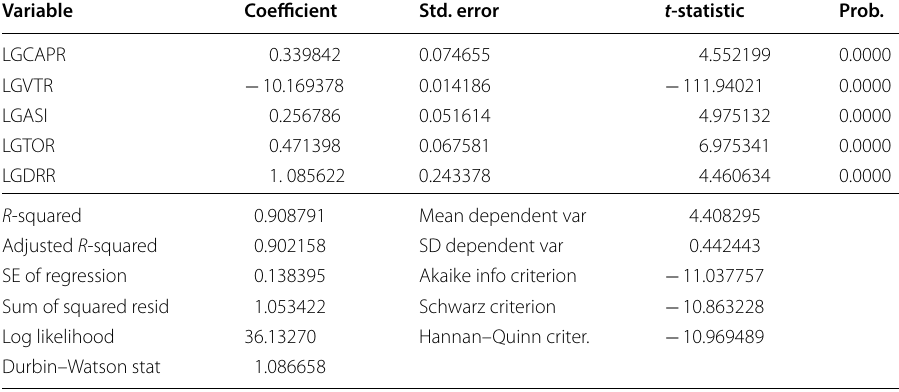
Table 12 Linearized non-stationary regression